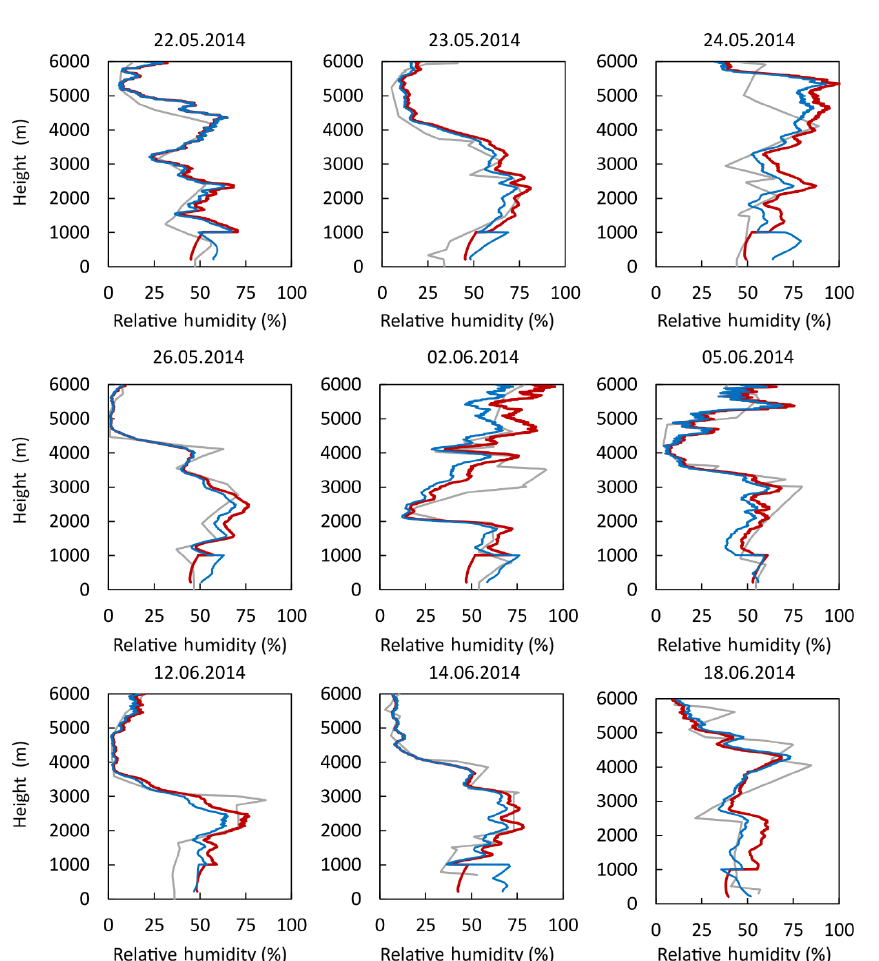
Figure 7. Vertical profiles of RH from combined methods: LD-WRF (blue) and LD-MWR (red) versus radiosounding (grey) for the dates when only low-resolution radiosoundings are available during June